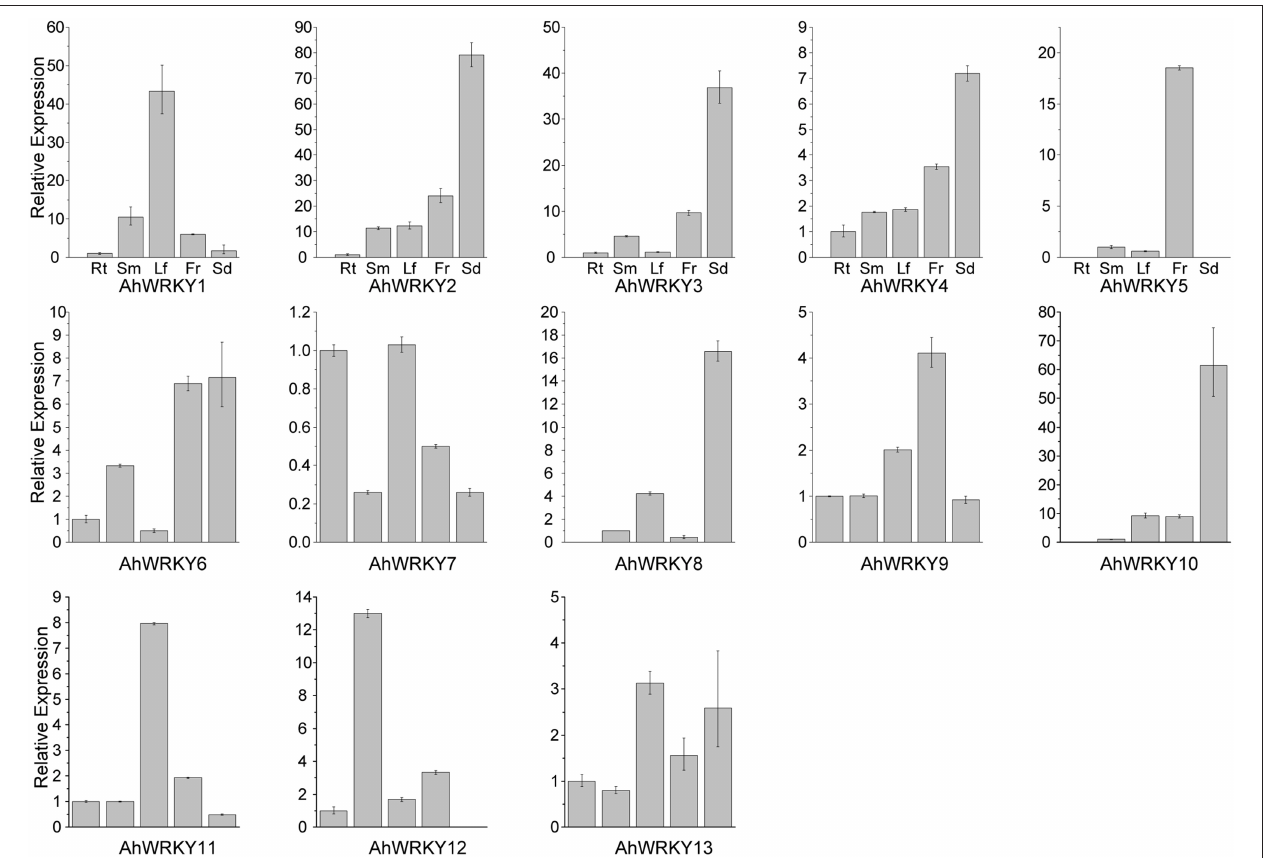
FIGURE 3 | The expression pattern of AhWRKY genes in different tissues. The abbreviation Rt, Sm, Lf, Fr, and Sd in the tissue label indicated root, stem, leaf, flower and seed, respectively.